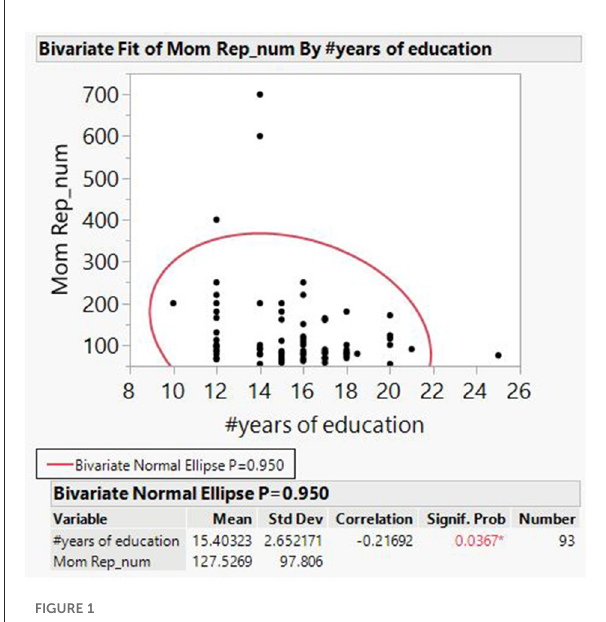
FIGURE1 Bivariate fit of number of CGG repetitions by years of